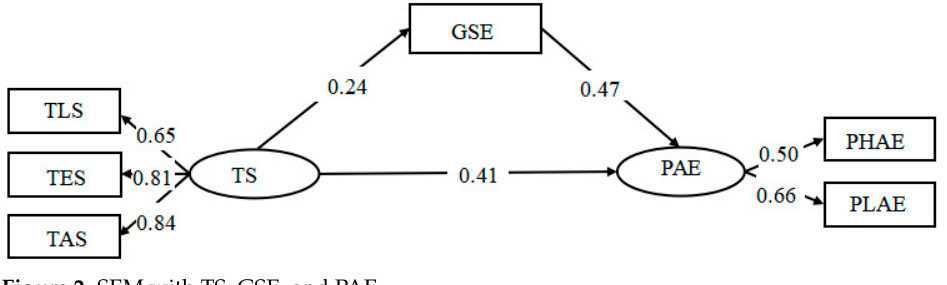
Figure 2. SEM with TS, GSE, and PAE.